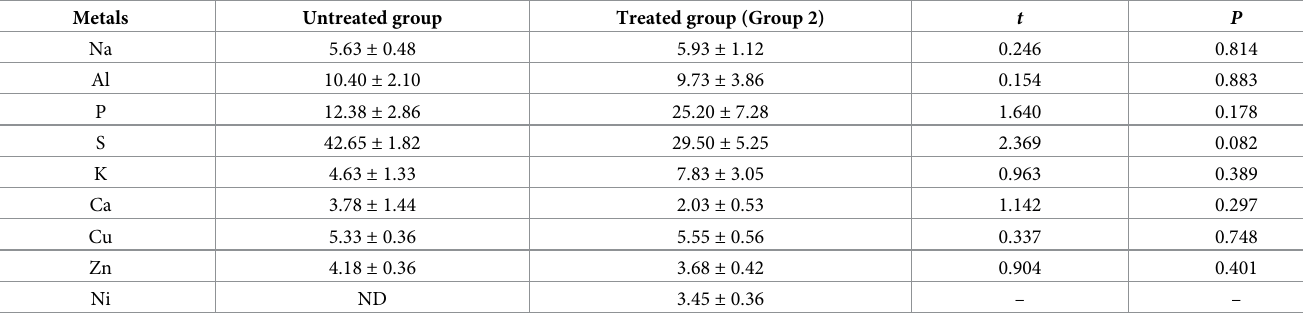
Table 2. Trace metal percentages (%) in midgut tissues of B . polycresta of the studied groups.